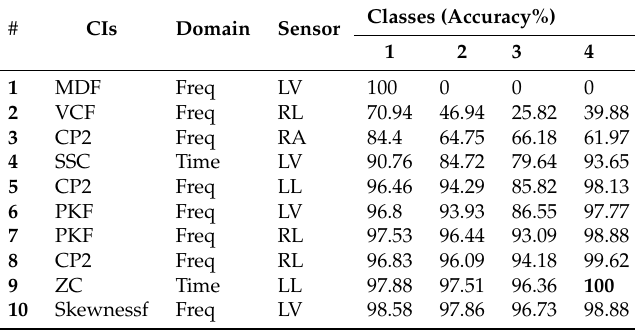
Table 11. Accuracy per class to